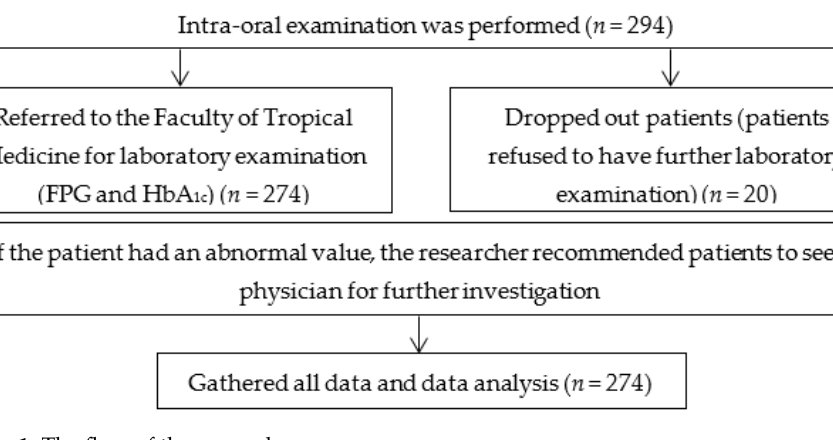
Figure 1. The flow of the research. Sample size calculation was determined, using the estimate prevalence of hyper- glycemia detected by RBG and HbA 1c and a formula for comparative two proportion [15]. At a significant level of 95%, power of 80%, estimated occurrence of hyperglycemia in dental setting being 30% [12] and hypothesized difference in prevalence of